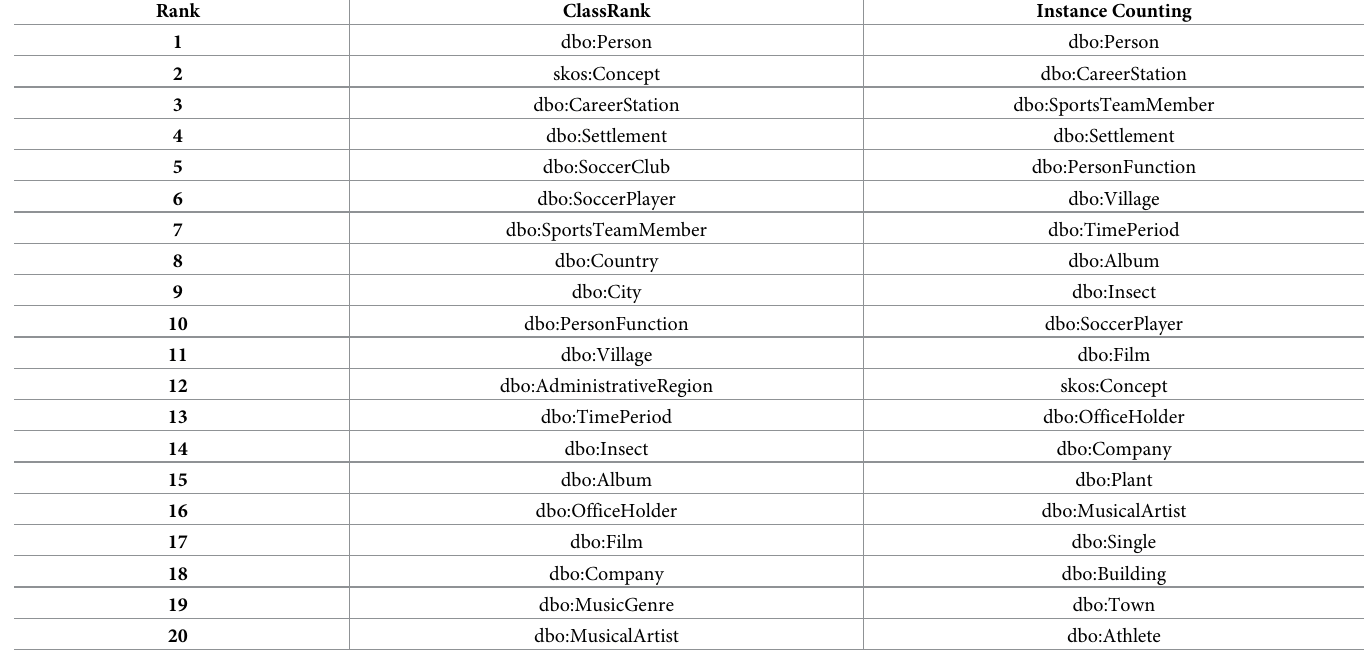
Table 7. Top 20 of ClassRank and Instance